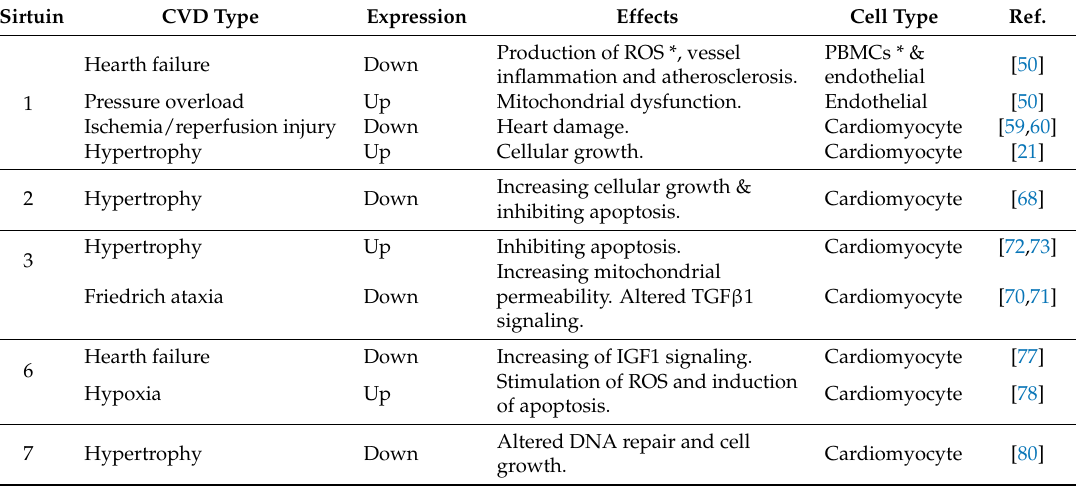
Table 2. Regulation and functional role of sirtuins in cardiovascular